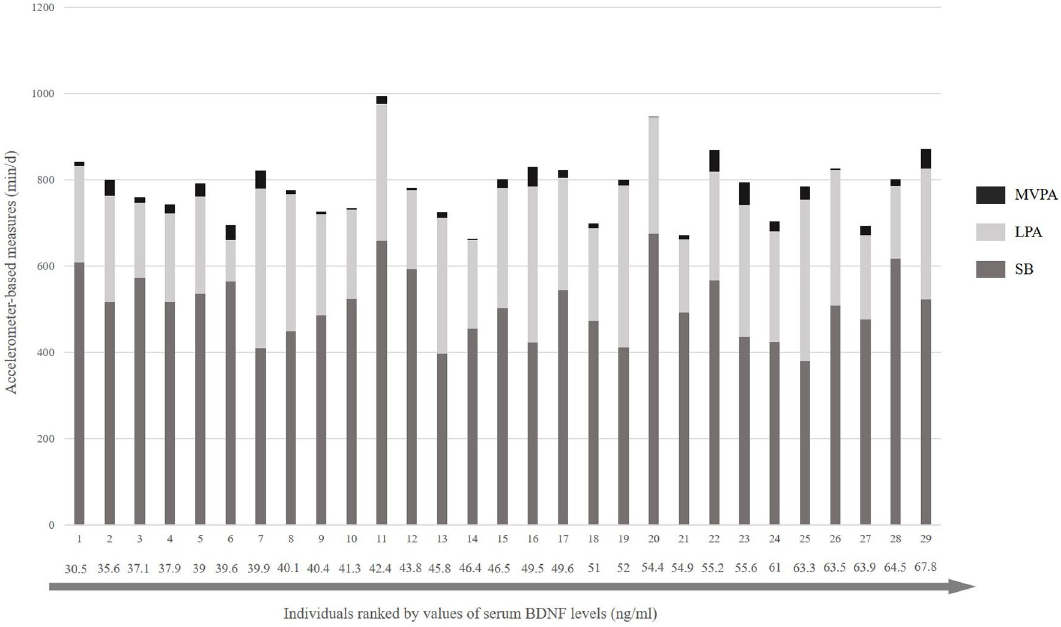
Figure 1. Total time spent in sedentary behavior, light physical activity, and moderate-to-vigorous physical activity among individuals with coronary heart disease (n = 29). Note. SB = Sedentary behavior, LPA = Light physical activity, MVPA = Moderate-to-vigorous physical activity, BDNF = Brain-derived neurotrophic factor. The dark grey segments represent the time spent in SB, the light grey segments represent the time spent in LPA, and the black segments represent the time spent in MVPA. Individuals are ranked by values of BDNF (ng/ml).